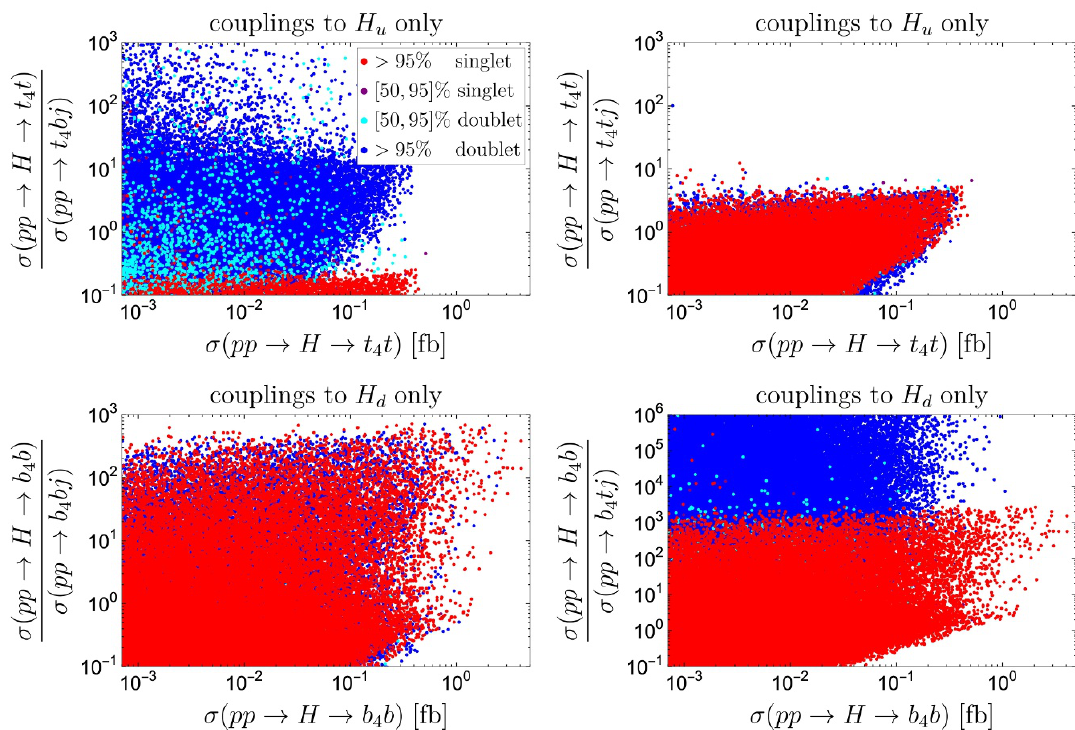
Figure 9 . Ratios of production rates of t 4 (top) and b 4 (bottom) in heavy Higgs cascade decays and single production modes. Results for scenarios with couplings to both H u and H d are